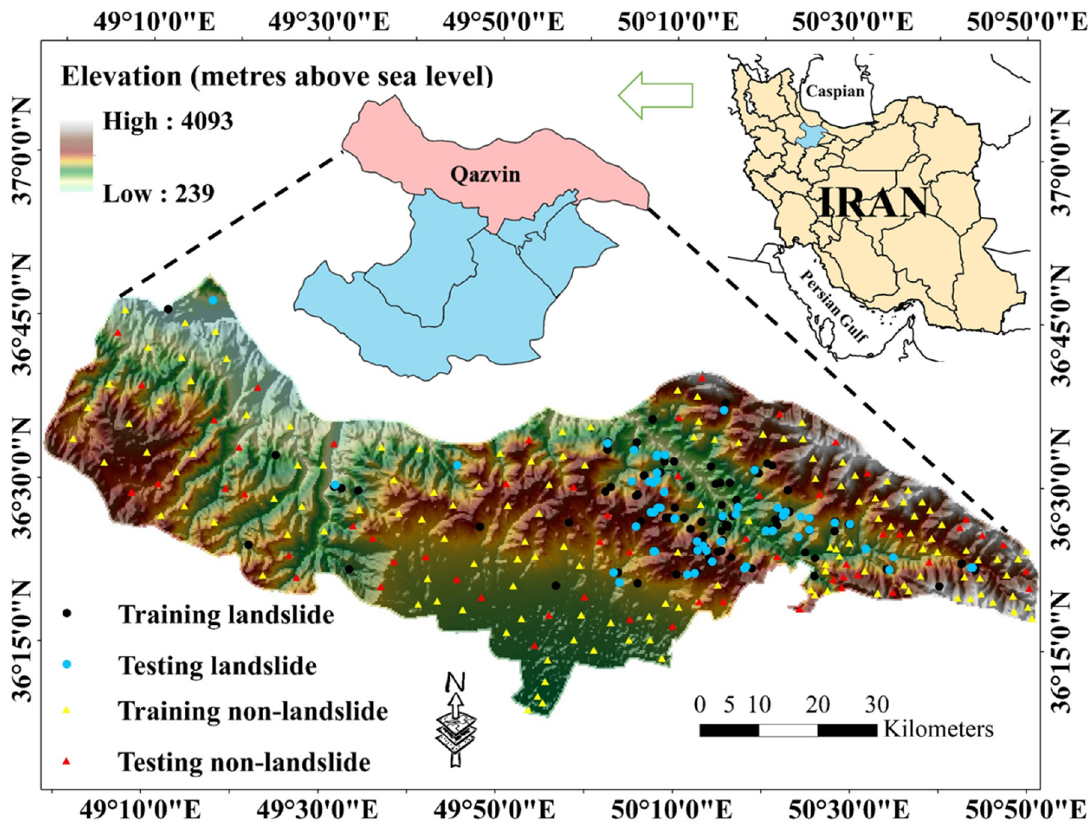
Figure 1. Location of the study area, and spatial distribution of landslides and non-landslide points.